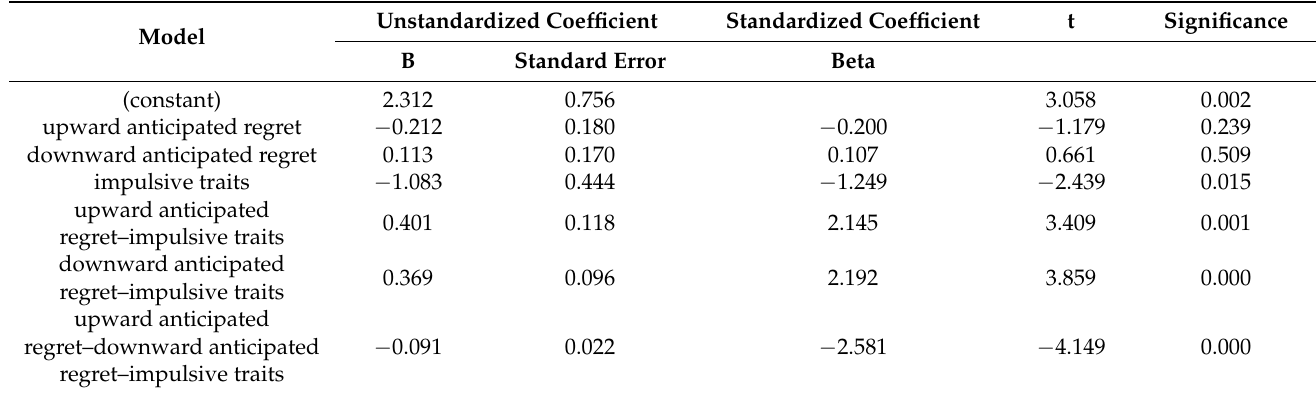
Table 17. Expected interaction of regrets and impulse